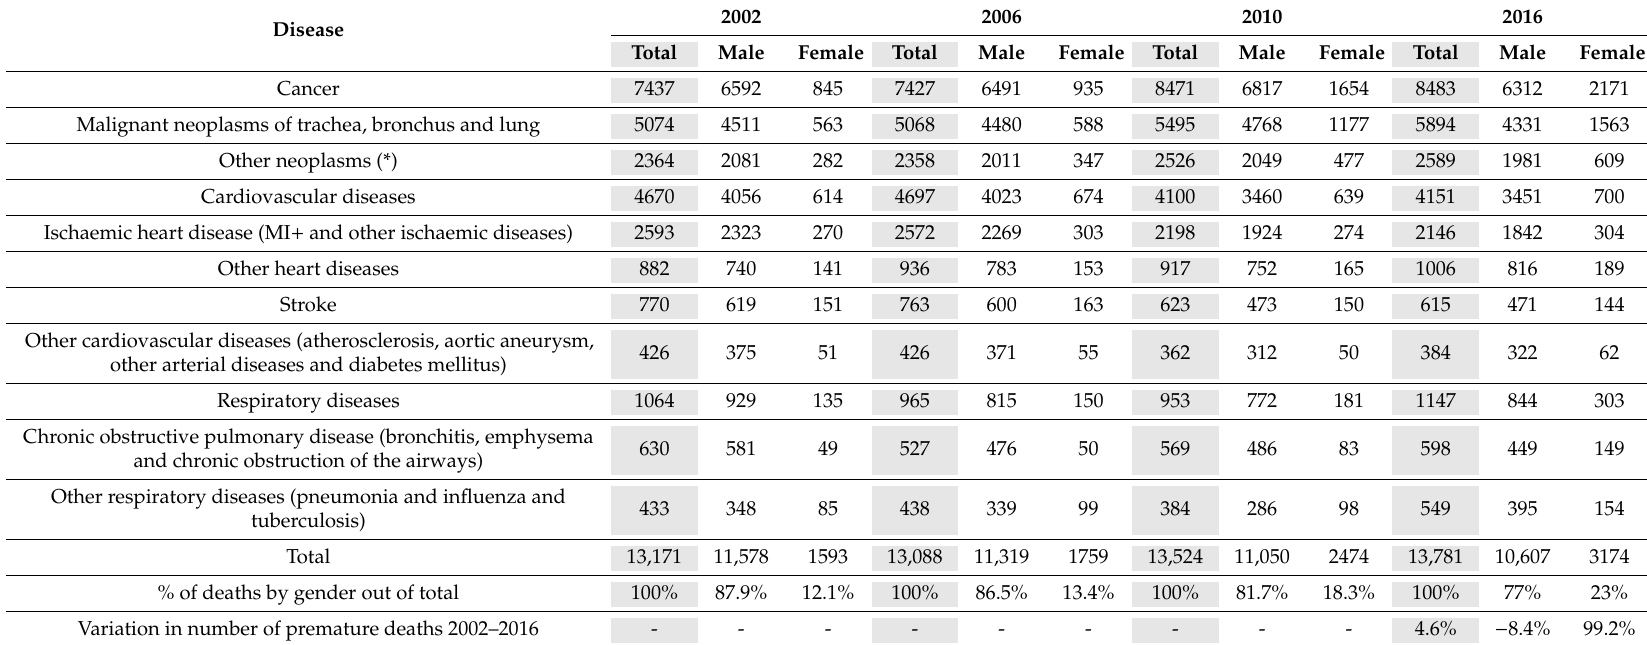
Table 1. Deaths in working age population (35 to 64